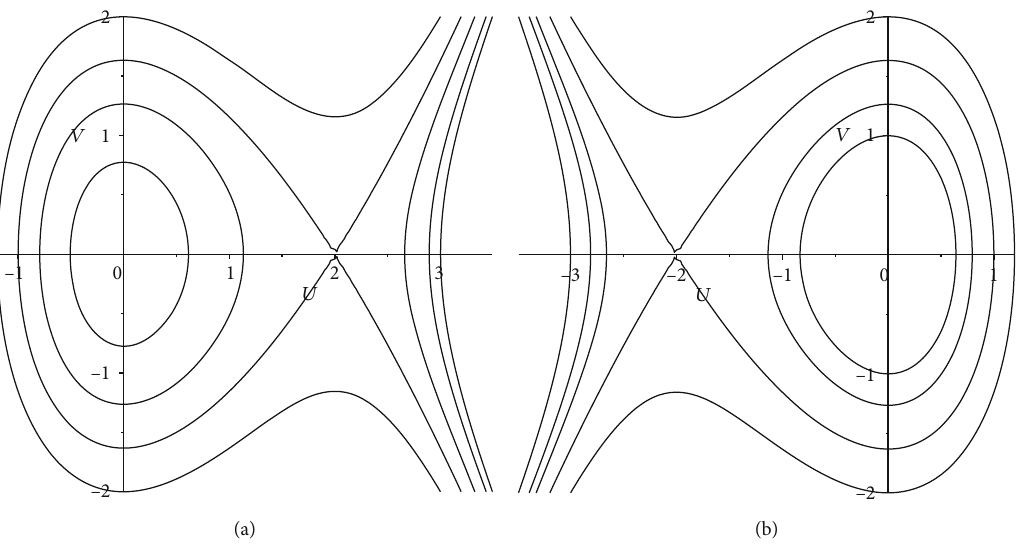
Figure 2: The phase portraits of the system (9) for B < 0 : (a) A > 0 ; (b) A < 0